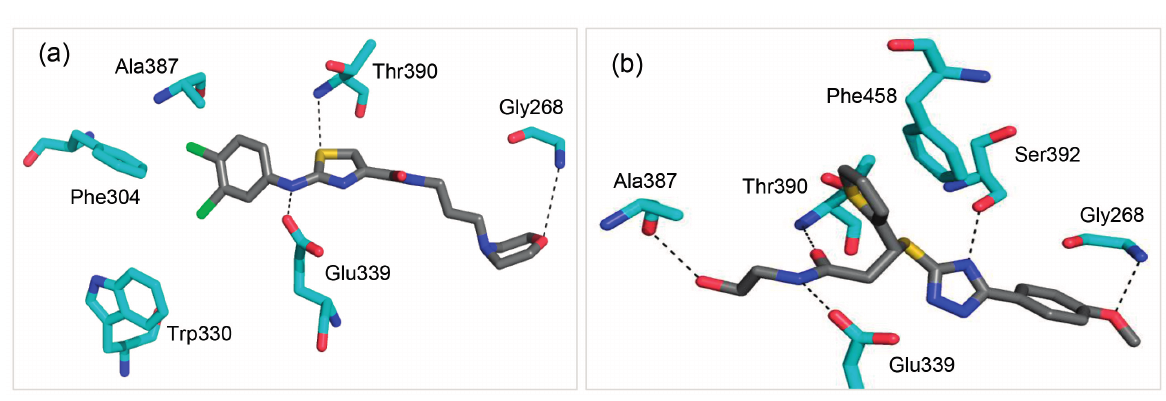
Figure 4. Predicted binding modes of the high-affinity control (HAC) and molecule A in the T-loop pocket of the crystal structure of NP. Carbon atoms of the two molecules are colored in dark grey while carbon atoms of NP residues interacting with the molecules are colored in cyan. Hydrogen bonds are represented by black dashes. ( a ) The HAC forms hydrogen bonds with Gly268, Glu339 and Thr390. Its dichloro-anilino group is involved in aromatic- π interactions with Phe304 and Trp330; ( b ) Molecule A forms hydrogen bonds with Glu339, Ala387, Thr390 and Ser392. Its thiophene group forms ring stacking with Phe458.